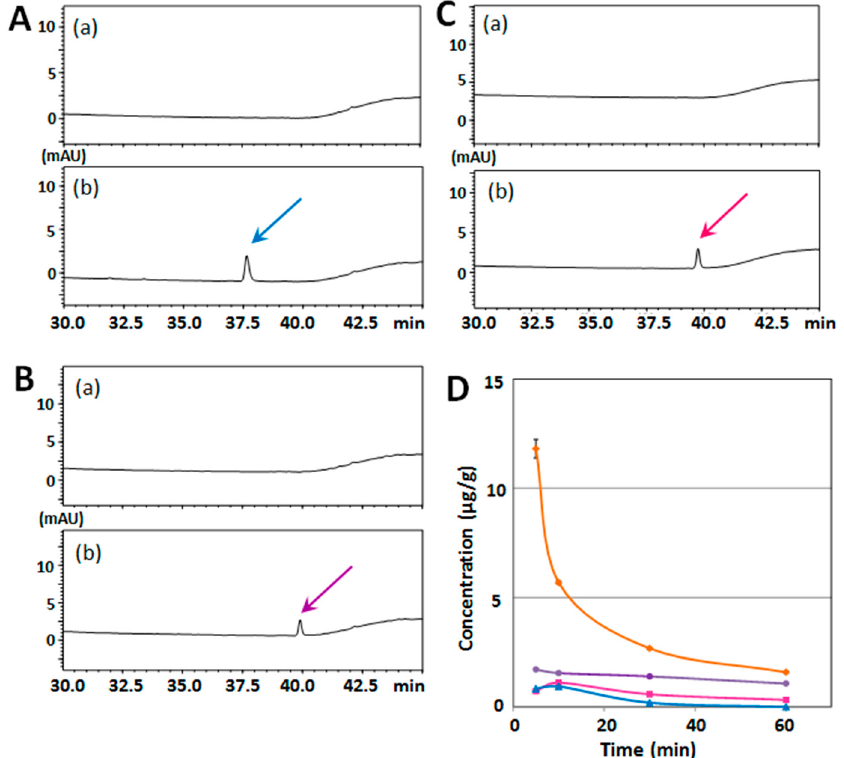
Figure 5. HPLC chromatograms of brain tissue from vehicle-treated mouse ( a ) and after ( b ) i.p. injection with NBT ( A ), TGT ( B ), or NDD ( C ). ( D ) Time-course of the brain concentration profiles of HMF (orange line), NBT (blue line), TGT (purple line), and NDD (red line) following i.p. administration. Colored arrows indicate respective PMFs. Values are the means ± SEM.